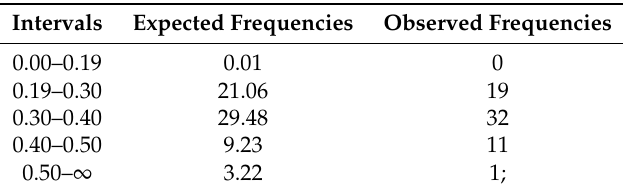
Table 9. Expected frequencies and observed frequencies for modified Data Set 2 when fitting the inverse Weibull model.